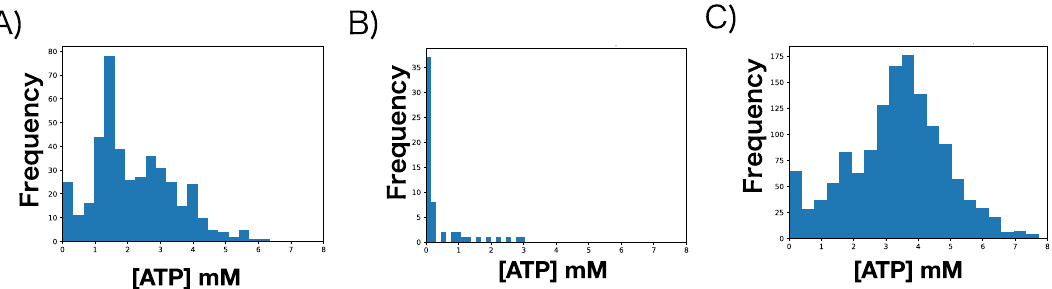
Figure 4. Comparison of intracellular ATP in cells cultured in glucose-corrected supernatants, ATP- supplemented control medium, and glycerol-supplemented control medium. ( A ) Distribution of intracellular ATP concentration in individual cells grown in a medium based on supernatants of glucose-deficient conditions (skewness = 0.559, P = 0.00001, n = 425). ( B ) Distribution of intracellular ATP concentration in individual cells grown in glucose control medium supplemented with 10 mM ATP (skewness = 2.070, P = 0.00000, n = 38). ( C ) Distribution of intracellular ATP concentration in individual cells grown in glucose control